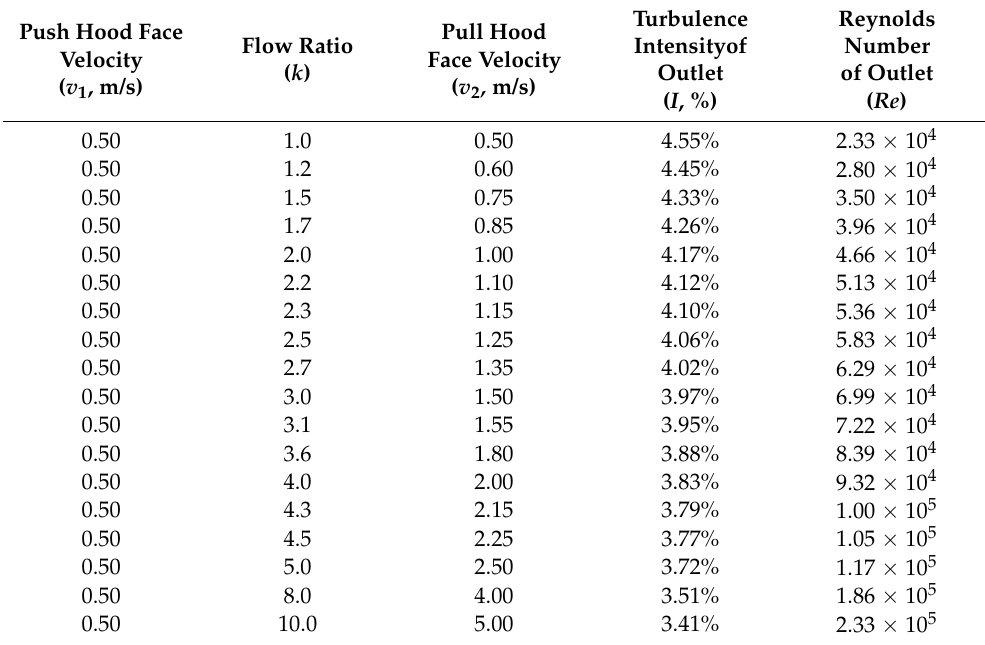
Table 1. The values of pull hood face velocity, turbulence intensity and Reynolds number of outlet at different flow